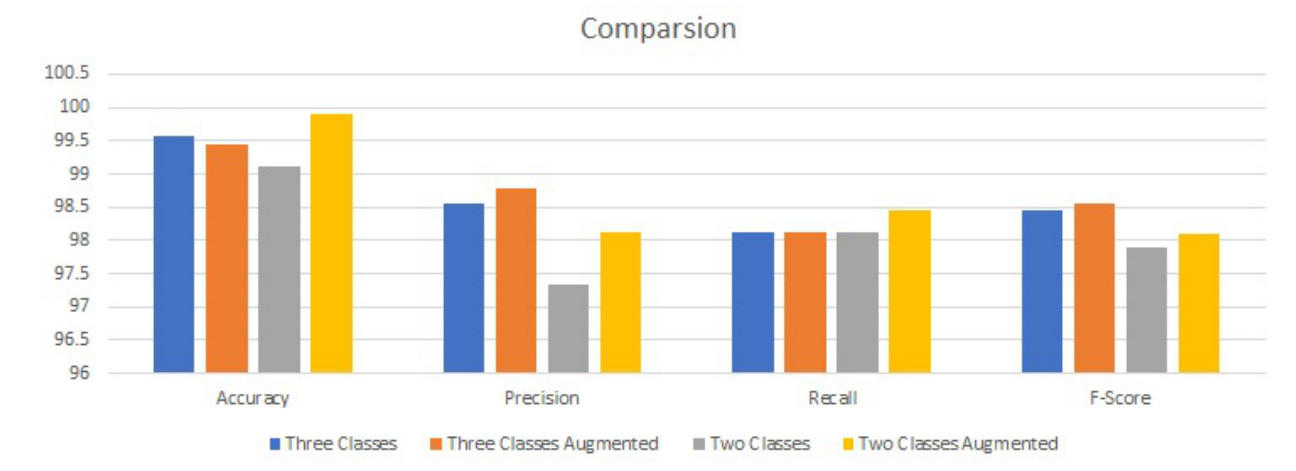
Figure 4. Analysis of different performance metrics on Proposed approach.